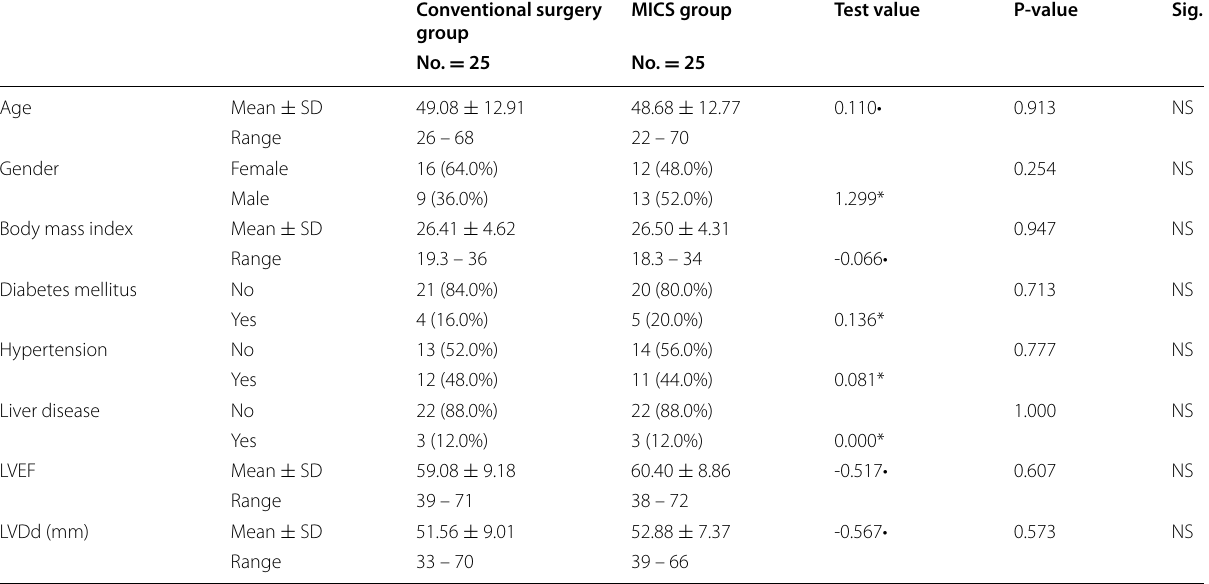
LVEF : Left ventricular ejection fraction, LVDd : Left ventricular end-diastolic dimension MICS : Minimally invasive cardiac surgery P is significant at 0.05, P is non-significant at > 0.05 ≤ * :Chi-square test; •: Independent